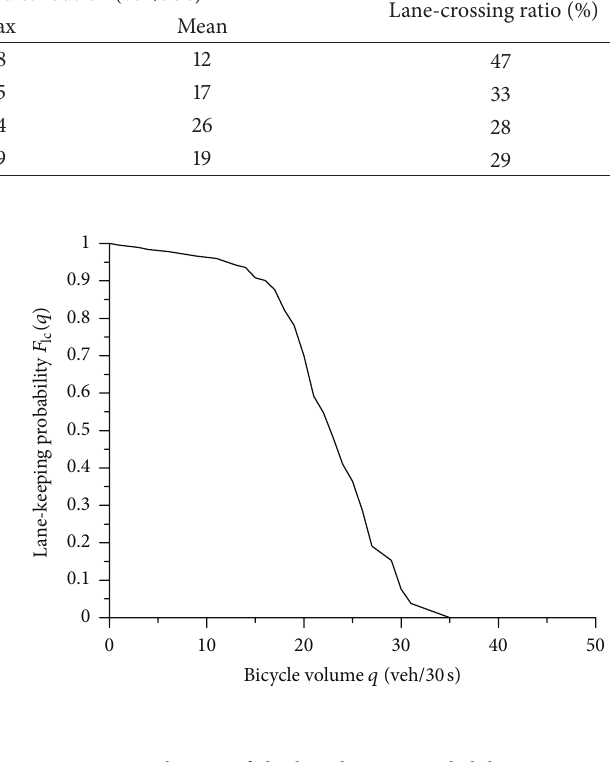
Figure 1: Distribution of the lane-keeping probability in average